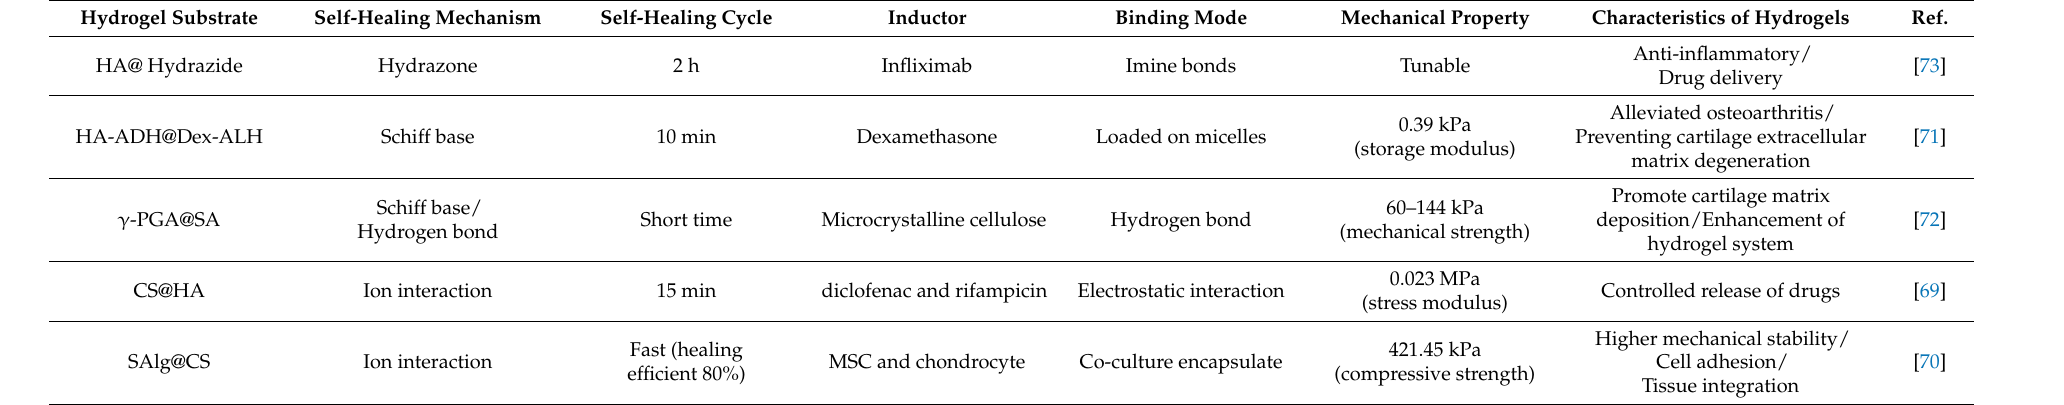
Table 2. Self-healing hydrogel for cartilage